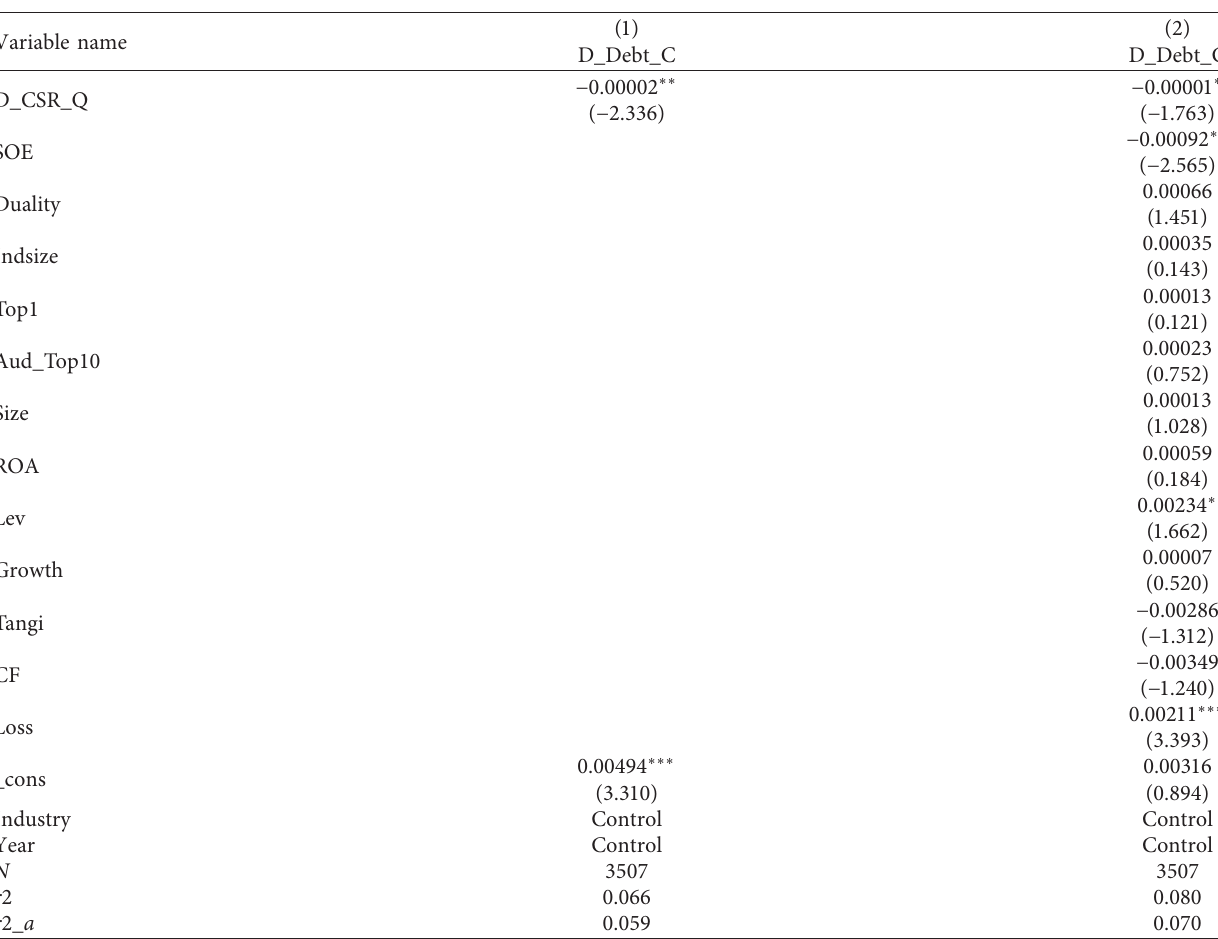
Table 10: Robustness test 3: first-order difference between explanatory and explanatory